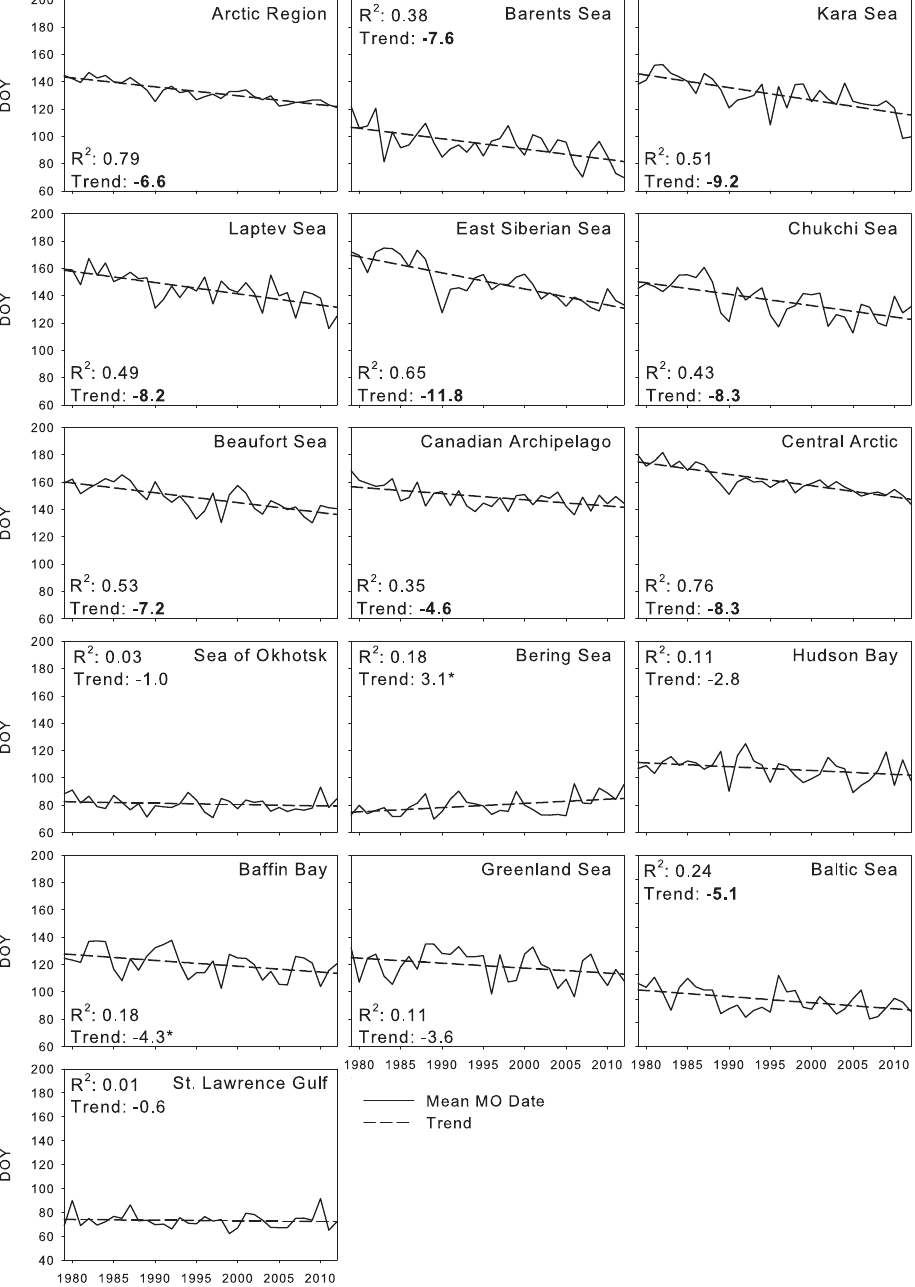
Figure 8. Time series of annual mean MO date and least squares linear regression trend for the Arctic Region and subregions. The R 2 value and decadal trend (daysdecade − 1 ) are shown for each region. Bold trends are statistically significant at a 99% confidence level. An ∗ indicates statistically significant trends at a 95% confidence